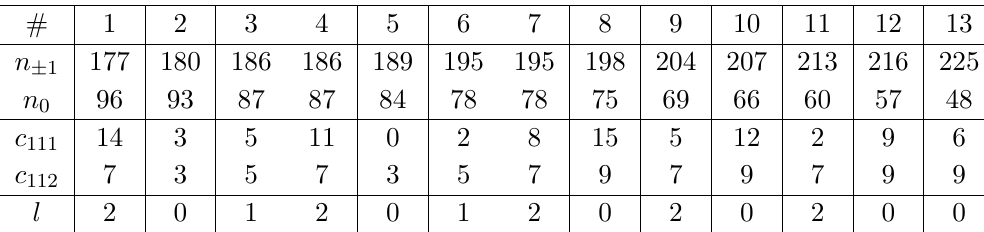
Table 2 . F-theory multiplicities n ± q of hypermultiplets with Z 3 charge ± q and triple intersection numbers c associated to 13 inequivalent Calabi-Yau threefolds that are genus one fibered with a ijk 3-section over P 2